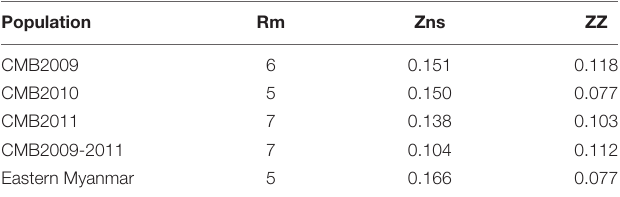
TABLE 2 | Linkage disequilibrium and recombination of pvdbp -II in China-Myanmar border and eastern Myanmar isolates. Population